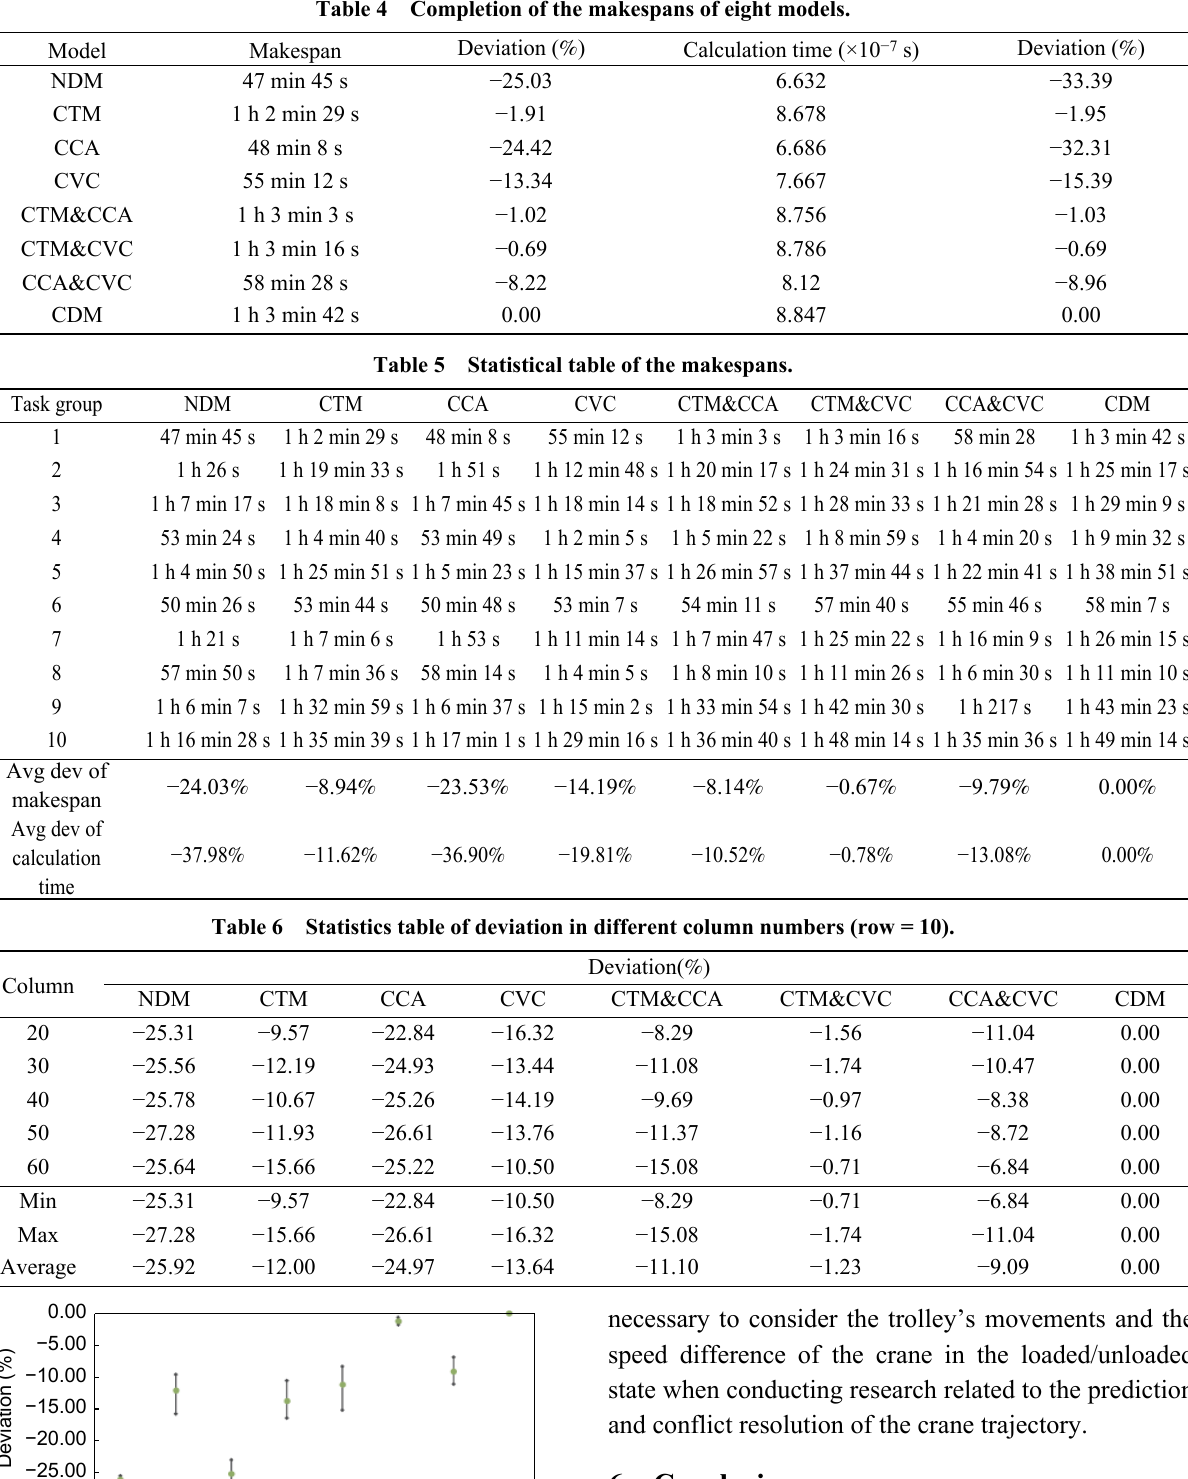
Table 4 Completion of the makespans of eight models.